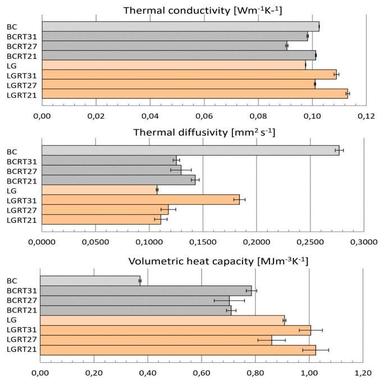
Thermal conductivity, thermal diffusivity and volumetric heat capacity of the composites.